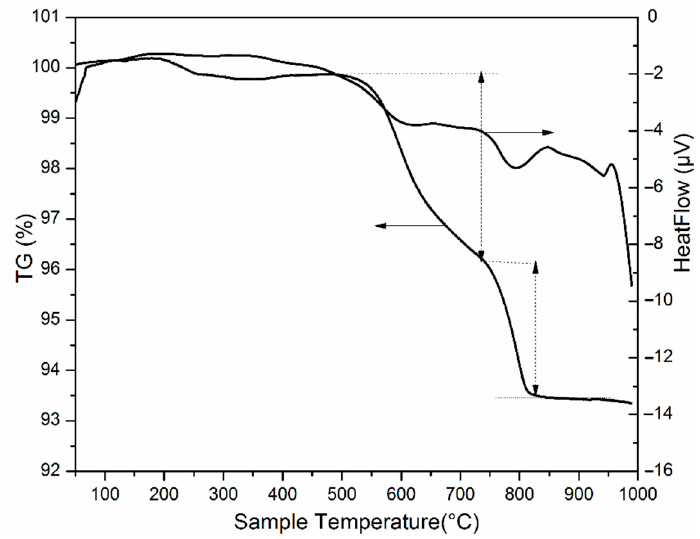
Figure 8. Thermal gravimetric analysis (left) and DTA (right) curves for the powder MnO 2 type α -MnO 2 synthesized using the hydrothermal method.